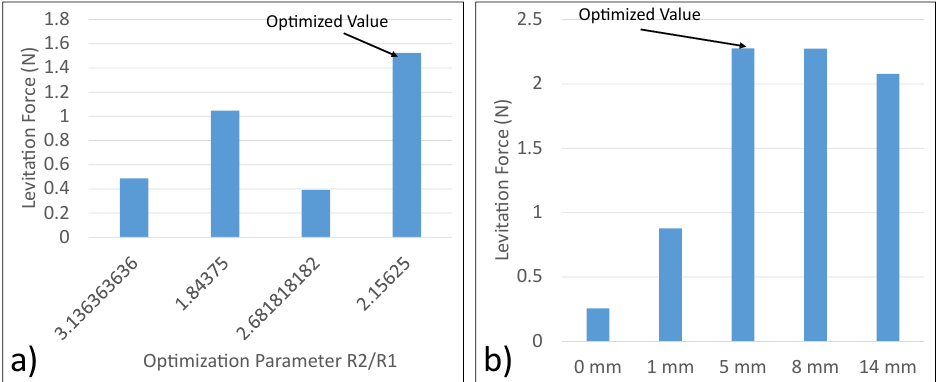
Figure 6. ( a ) Optimization of radial placement of coils; ( b ) Optimization of baseplate